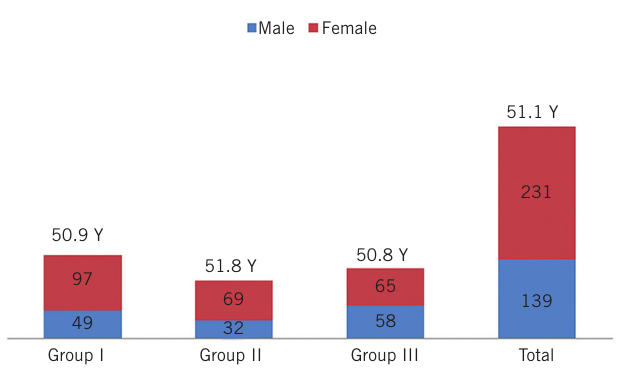
figuRE − Total number, mean age (y) and gender (female/male) of patients with normal gastric mucosa (Group I), chronic gastritis with mild inflammatory activity (Group